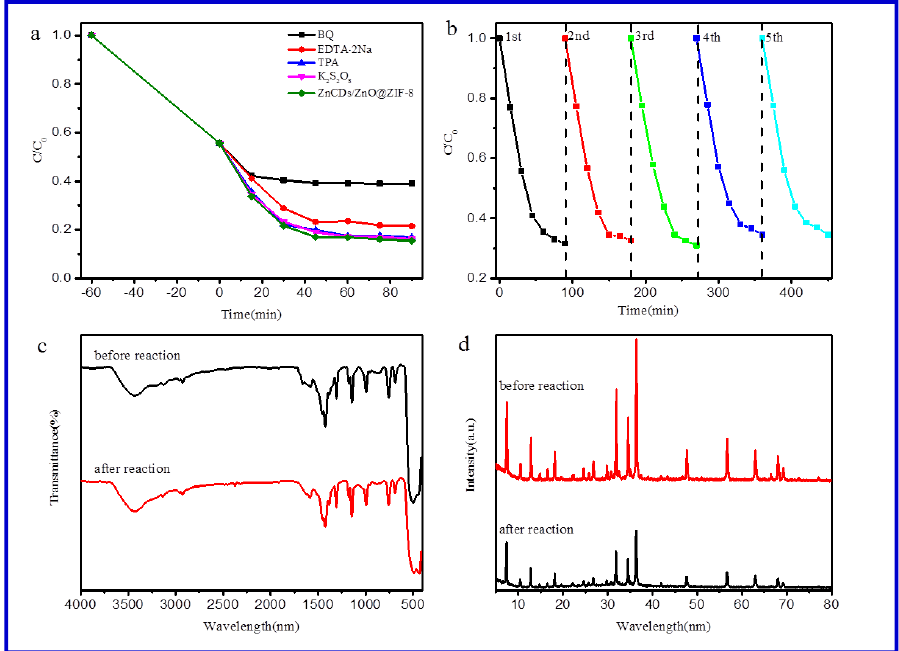
Figure 9. ( a ) Time-dependent photodegradation of TC over Zn-CDs/ZnO@ZIF-8 in the presence of different scavengers. ( b ) Cycling runs of Zn-CDs/ZnO@ZIF-8 ( c ) IR of Zn-CDs/ZnO@ZIF-8. ( d ) XRD of Zn-CDs/ZnO@ZIF-8 before and after reaction.